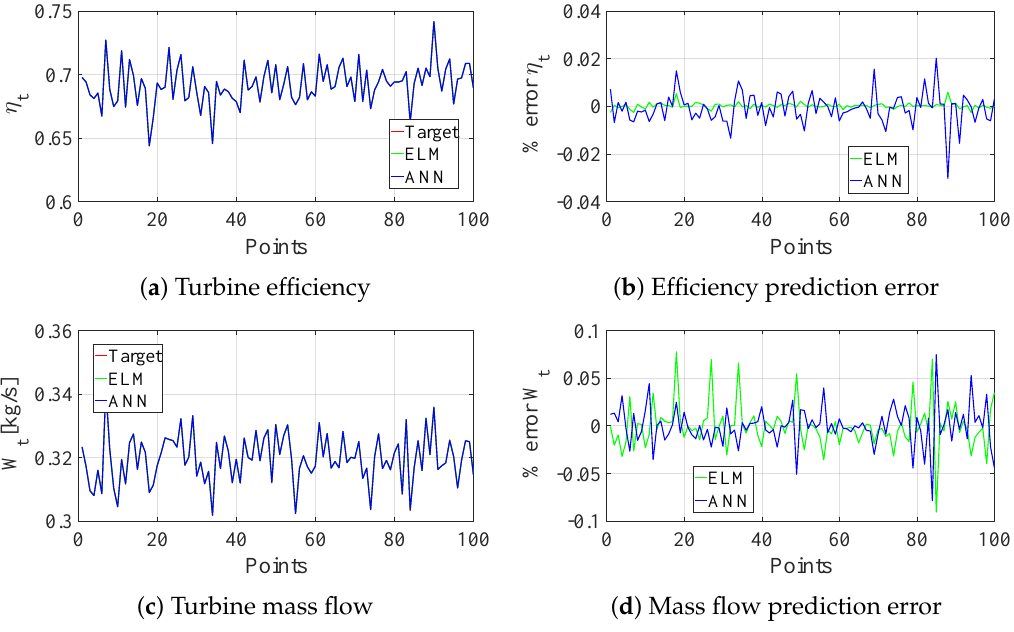
Figure 9. Turbine degradation in flight regime 1 with input vector 1: comparison between the target and prediction of the component performance